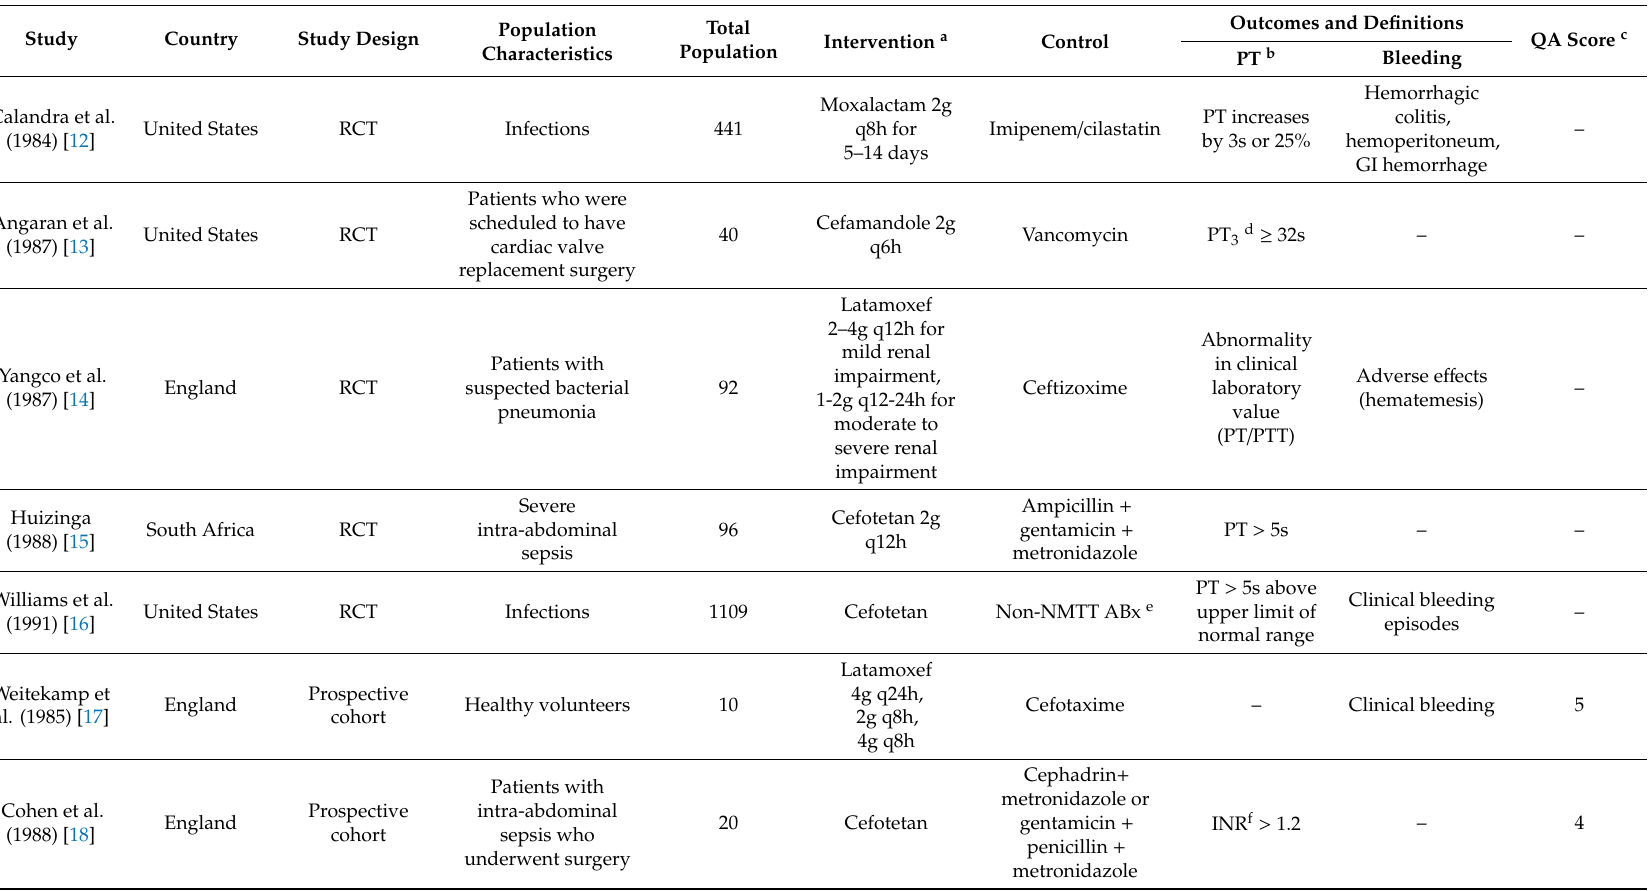
Table 1. Characteristics of included